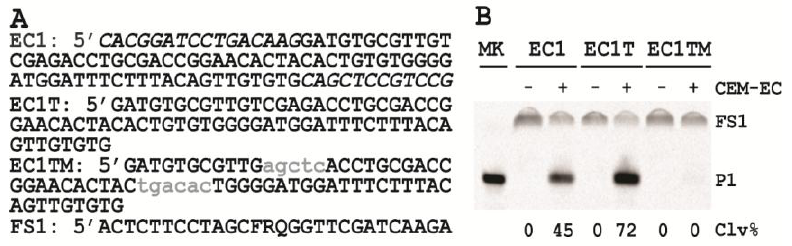
Figure 1. Design of trans -acting DNAzymes. ( A ) The sequences of EC1, EC1T, EC1TM and FS1. EC1 is the full length DNAzyme including two primer binding sites (nucleotides in italic) for polymerase chain reaction used in the original in vitro selection experiment. EC1T is the shortened version of EC1 with deleted primer binding sites. EC1TM is a mutant of EC1T wherein the nucleotides shown as lower-case letters are altered. The substrate FS1 contains an adenosine ribonucleotide (R) flanked by a fluorescein-dT (F) and a DABCYL-dT (Q). ( B ) dPAGE analysis of the cleavage reaction mixtures of FS1 with EC1, EC1T, or EC1TM in the absence (−) and presence (+) of CEM-EC. P1 represents the 5’-cleavage product, which can be observed by fluorescence scan as it contains the F unit. MK (marker) is a sample of FS1 fully cleaved by NaOH. Clv% for each sample